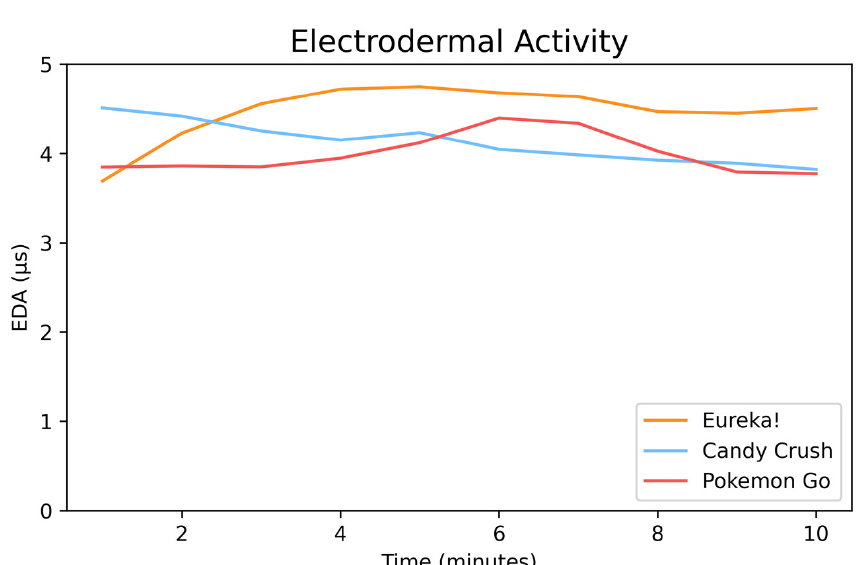
Figure 7. Relation of the three games with the EDA.